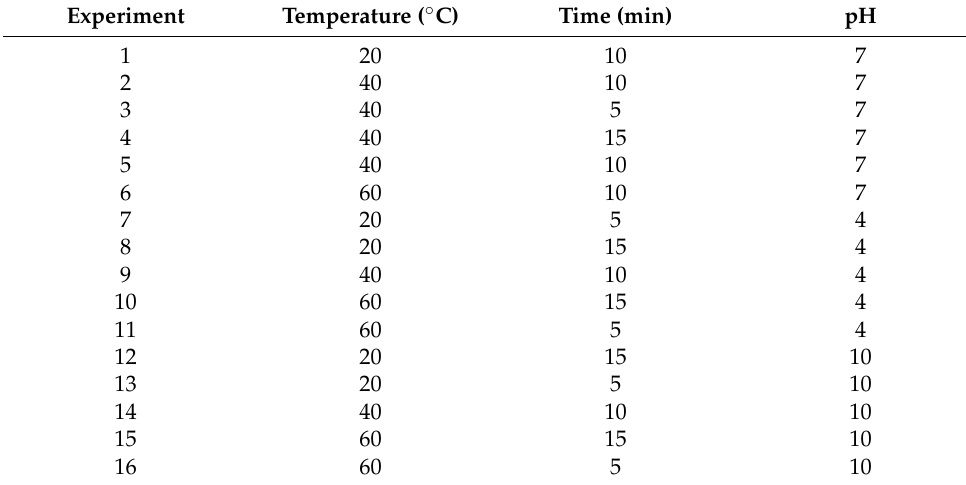
Table 1. Response surface methodology—central composite